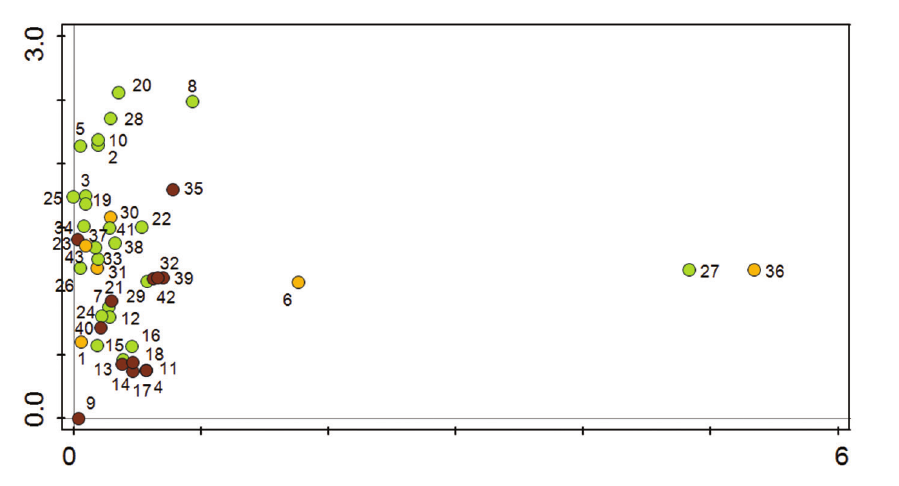
Figure 3. The ordination analysis (CANOCO 5, unconstrained analysis, DCA) of individual localities (1–43) in the White Carpathians according to present terrestrial isopod assemblages. For numbers of indi- vidual localities, see Materials and methods. Key: brown spots, forest localities; light green spots, meadows and pastures; yellow spots, localities of mixed meadows and